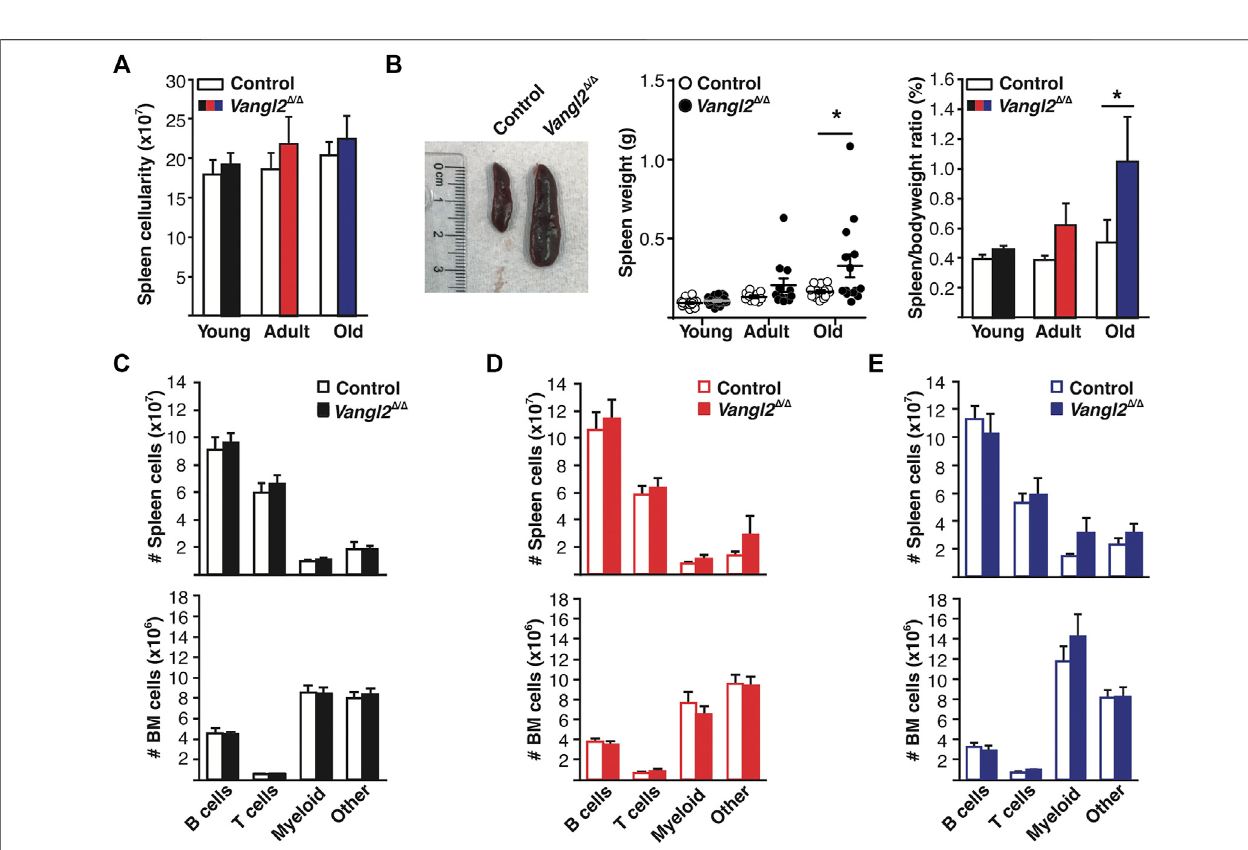
FIGURE 2 | Vangl2 is dispensable for steady-state lympho-myelopoiesis, but its absence promotes splenomegaly in old mice. (A) Spleen cellularity for young (2- month-old), adult (6-month-old) and old (18-month-old) mice (mean +SEM). (B) Photograph of an enlarged Vangl2 Δ / Δ spleen (left). Spleen weight for individual mice (middle;horizontallines represent meanand errorbars, SEM) and averagespleen index asdetermined by thespleenweight (g)/bodyweight (g) ratio(right;mean +SEM). (C-E) Histograms represent absolute spleen (top panels) and BM (bottom panels) B lymphocyte (CD19 + ), T lymphocyte (CD3 ε + ), and myeloid (CD11b hi ) cell numbersfor (C) youngmice, (D) adultmice,and (E) oldmice(mean+SEM).CD19 − CD3 ε − CD11b − /lo cellsarerepresentedas “ Other ” .Seealso SupplementaryFigure S1,S2 . Young (n = 17 control, 19 Vangl2 Δ / Δ ), adult (n = 10 control, 11 Vangl2 Δ / Δ ), old (n = 14 control, 14 Vangl2 Δ / Δ ), * p ≤ 0.05.